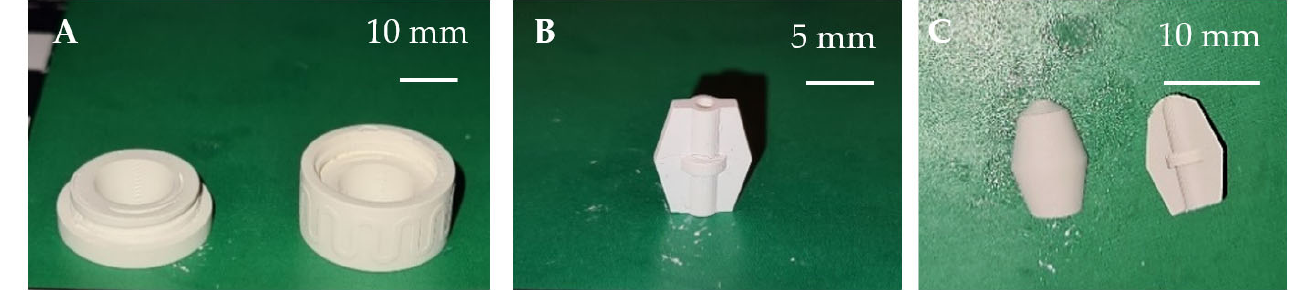
Figure 9. Printed “core–shell” in the green state, zirconia ( A , B ) and titania ( C ).